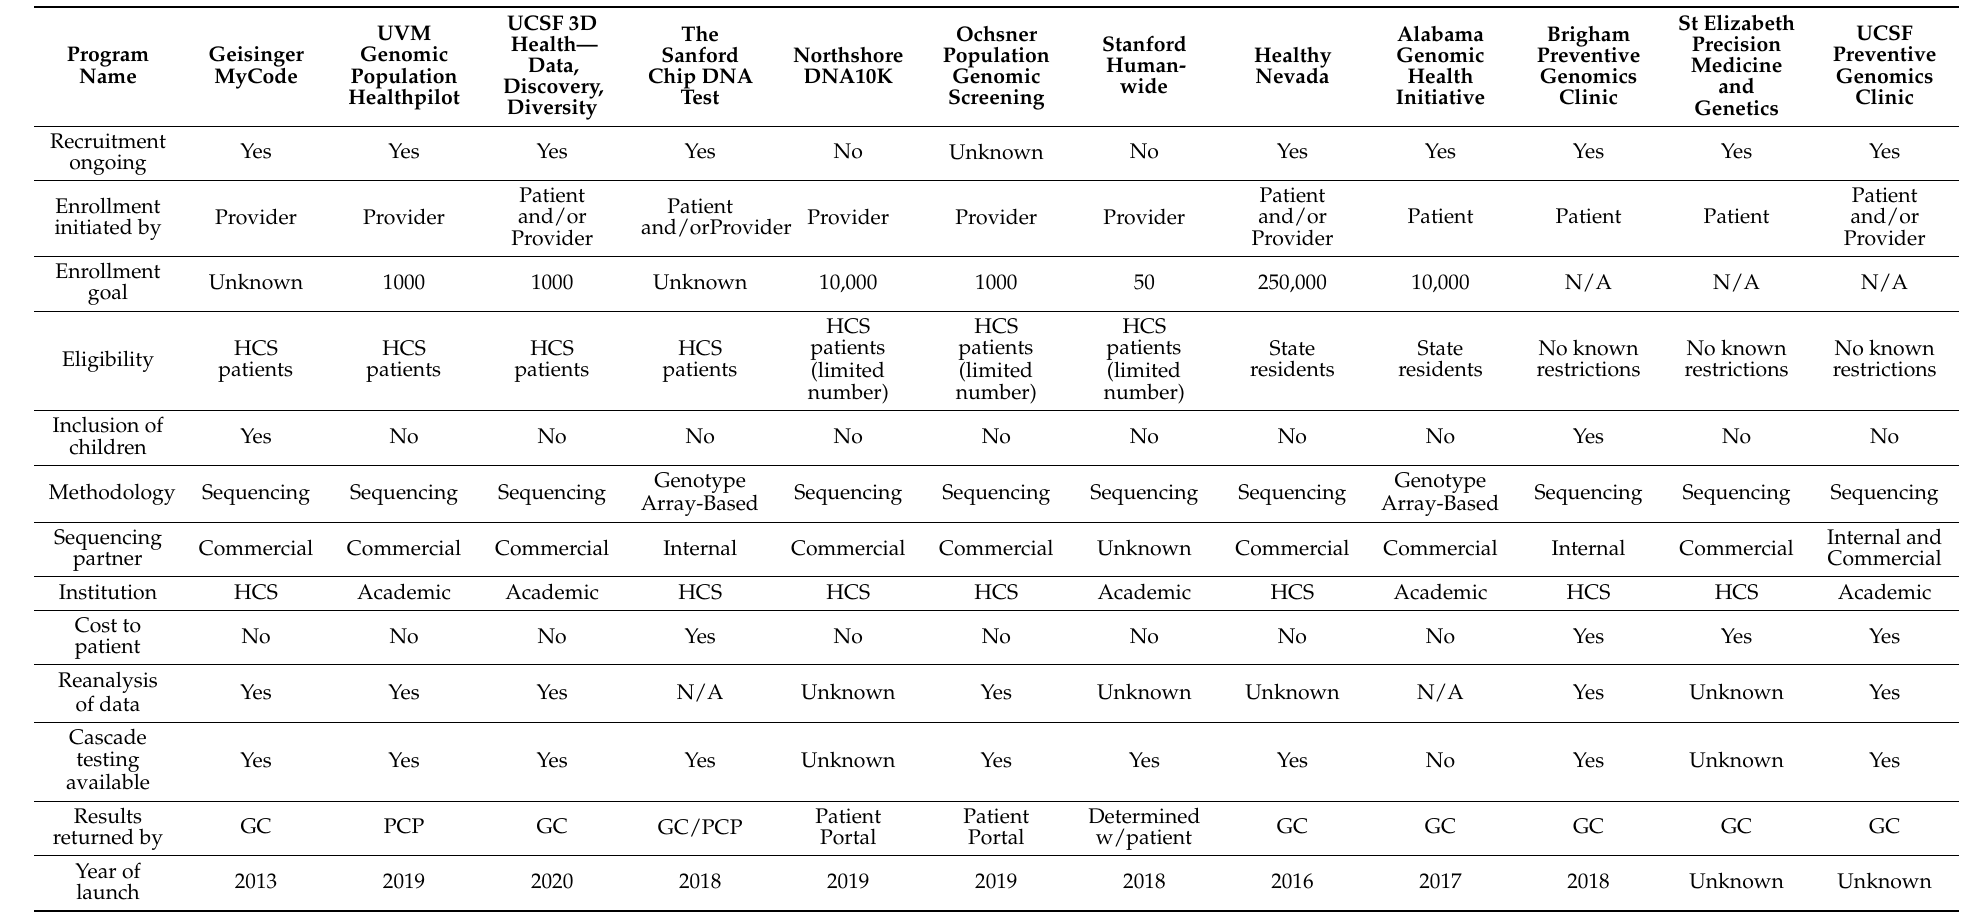
Table 3. Program